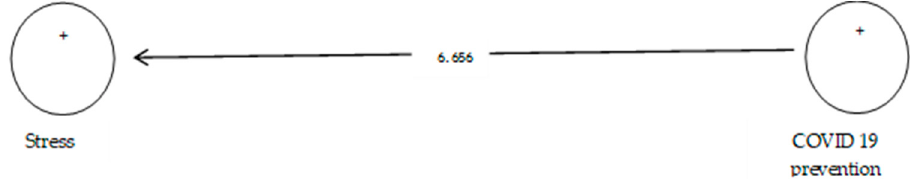
Figure 13. Drawn model with significant coefficients z. Table 9. Evaluation indicators of the internal model of the research, direction and significance of direct effects.